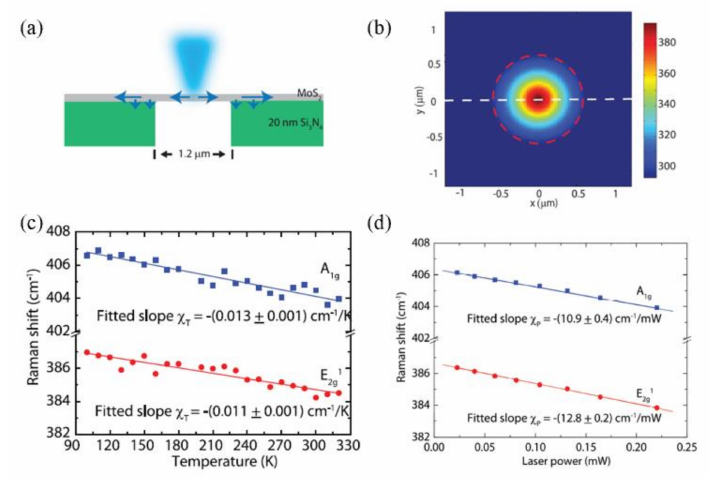
Figure 5. Illustration of optothermal Raman methods. ( a ) Schematic of the thermal conductivity measurement showing suspended MoS 2 flakes and excitation laser light. ( b ) Simulation of laser heating temperature rise. ( c ) Raman peak frequency shift as a function of temperature. ( d ) Experi- mental data for Raman shift as a function of laser power, which determines the local temperature rise in response to the dissipated power. Reprinted with permission from Ref. [47]. Copyright 2014, American Chemical